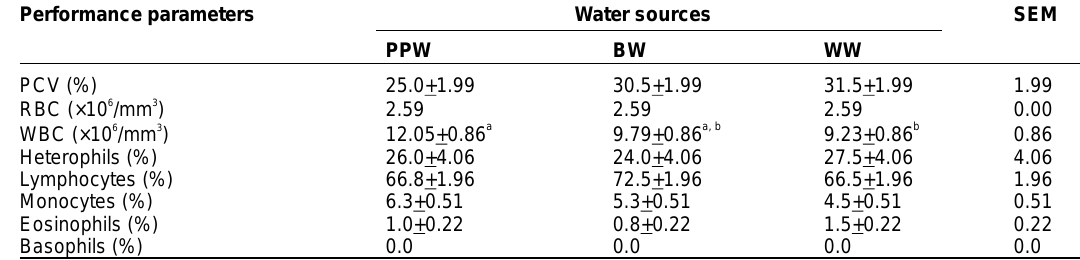
Table-5. Haematological variables of broiler chickens given different sources of water Performance